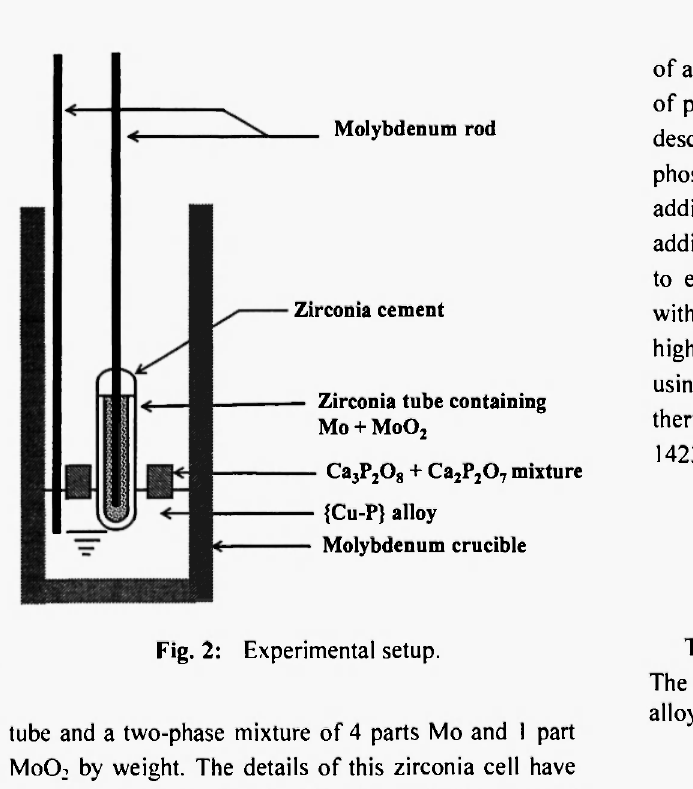
Fig. 2: Experimental